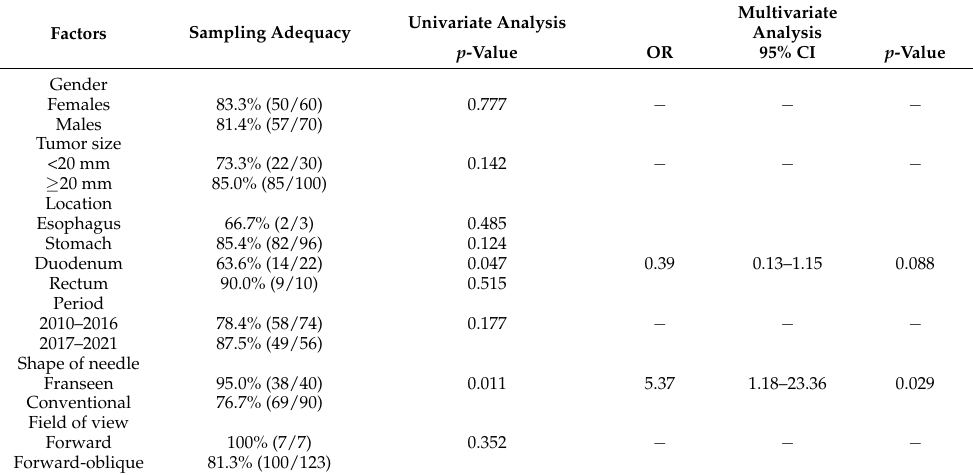
Table 4. Factors influencing the sampling adequacy of EUS-FNA for SELs ( n = 130).